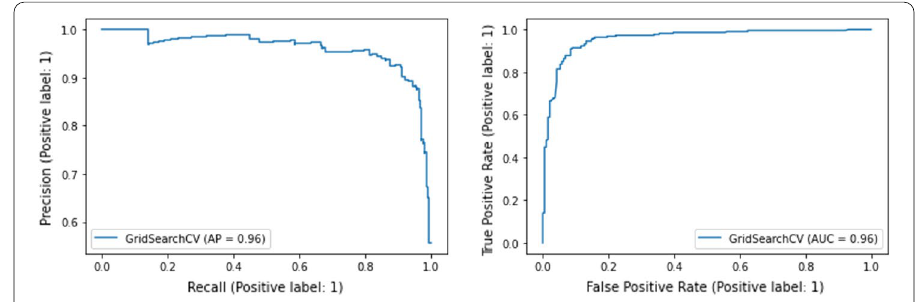
Fig. 3 The Average Precision (AP) curve (left) and the Receiver Operating Characteristic (ROC) curve (right) for the best performing Random Forest